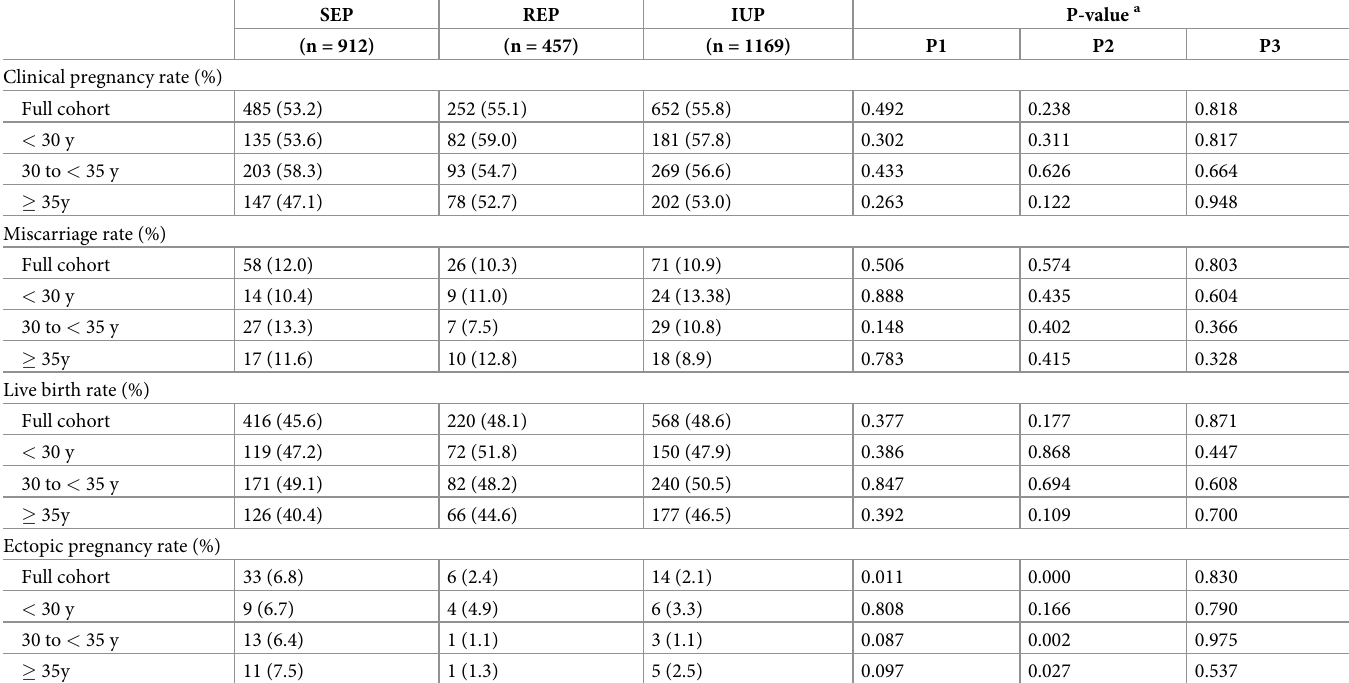
Table 3. Pregnancy outcomes after IVF/ICSI, stratified by maternal